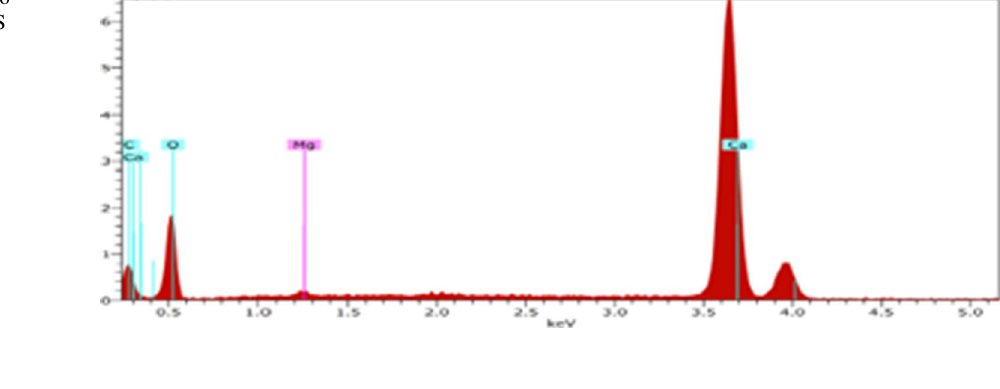
Fig. 1 Results of X-Ray fluo- rescence for Magnesia-1 LS subsample